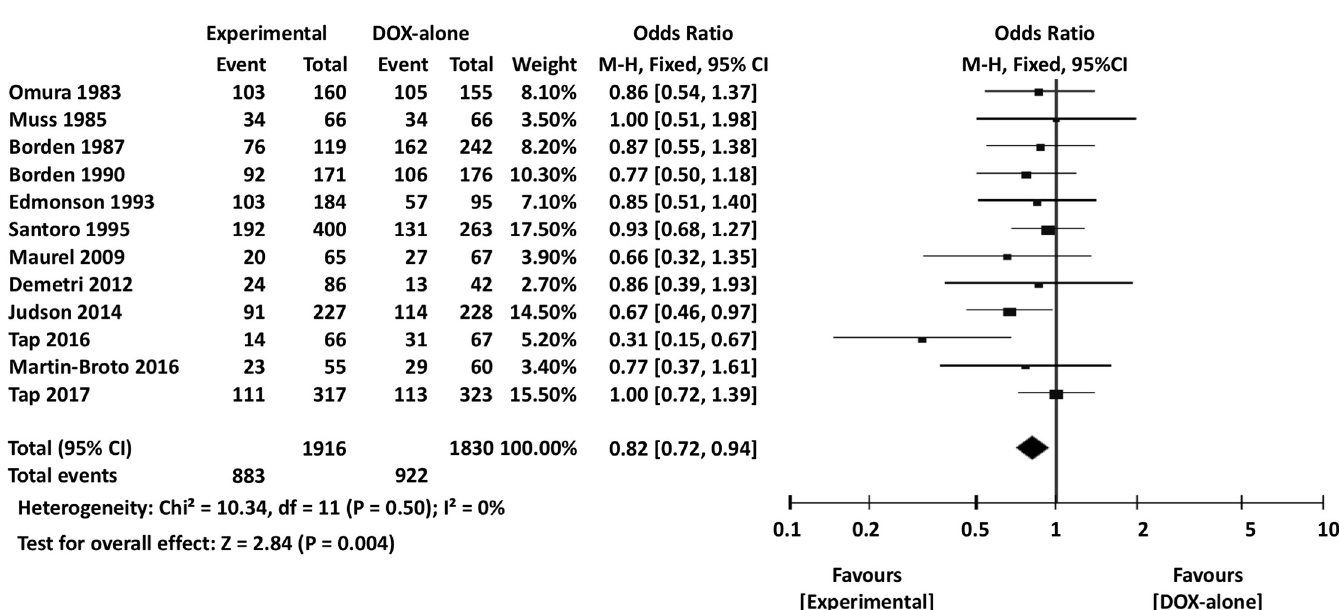
Fig 8. Comparisons of doxorubicin alone vs experimental chemotherapy: Forest plots of the incidence of severe nausea/vomiting adverse events. CI, confidence interval; M-H, Mantel-Haenszel.